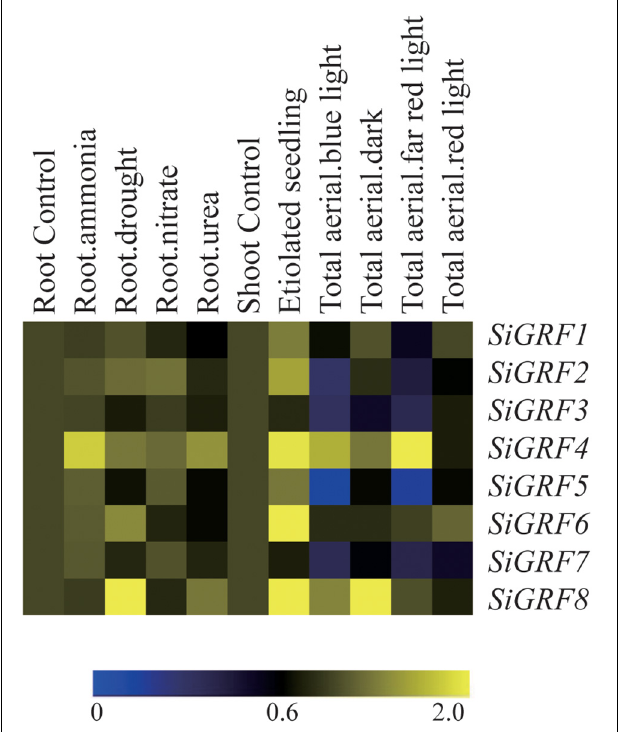
FIGURE 3 | Expression profiles of SiGRF genes differentially expressed under stress and light conditions. The values of SiGRF genes under the control (untreated) and various stress conditions (labeled at the top of each lane) are presented by cluster display. The color scale representing signal values is shown at the